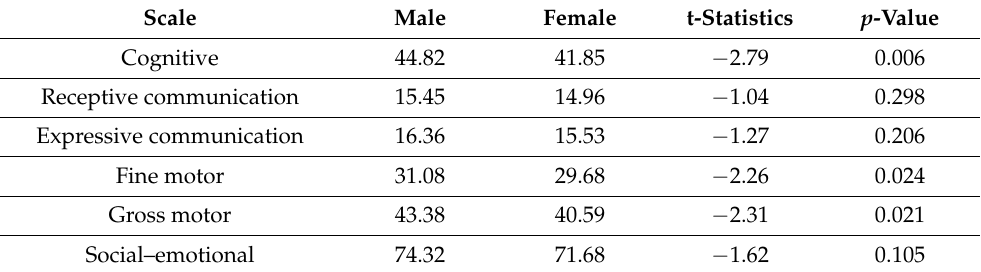
Table 3. BSID-III raw scores by